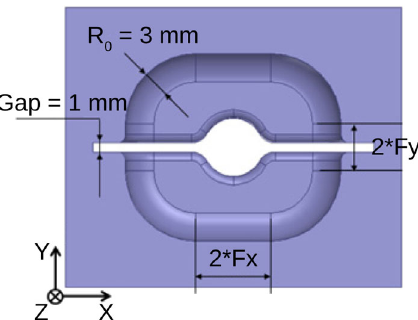
FIG. 5. A cross section of the cell geometry with parameters F x and F y which represent size of the flat region of the racetrack design [9].